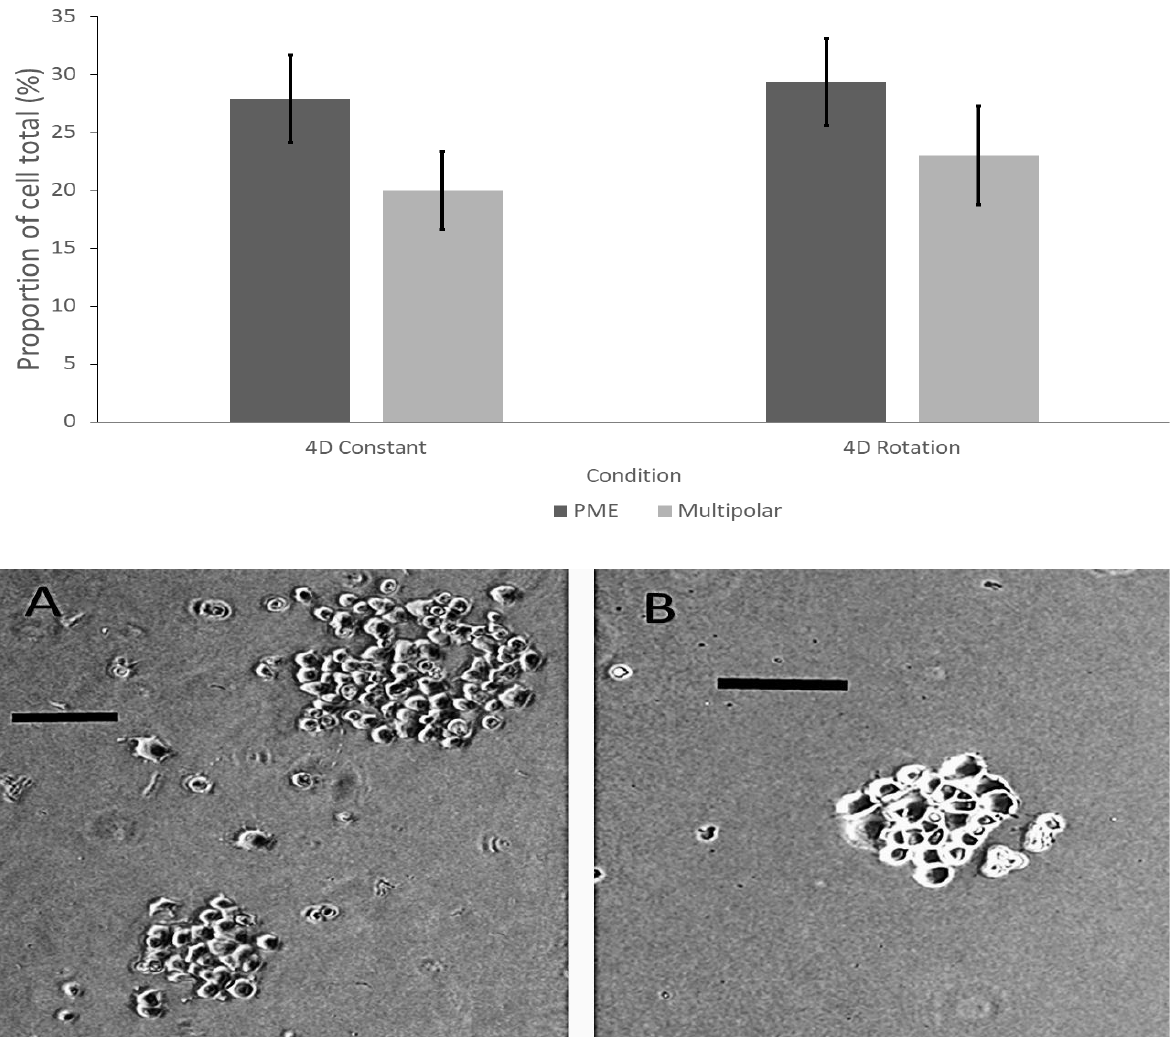
Figure 2. PC12 cells were exposed to Burst-firing EMF in the 4-D box as a function of spatio-temporal pattern of presentation (constant versus rotated) and the proportion of PME determined and compared. The graph (upper panel) demonstrates differences in the proportion of PME (dark bar) and multipolar extensions (light bar) across EMF exposure conditions. Error bars in the graph represent SEM. For each condition (constant and rotation), each trial was conducted in triplicate, 2 plates were conducted in parallel, and 4 samples per plate were photographed for cell counts in each condition. Both the constant and rotated exposures were conducted on PC12 cells that were treated with 0.5μM of forskolin. Supporting photos show representative images of cells exposed to the constant ( A ; left) and rotated ( B ; right) 1 hour, Burst-firing EMF. Darkened bars were fitted to original photos prior to their adjustment. Each darkened bar approximates 100 um in length for the individual photo for which they have been fitted.